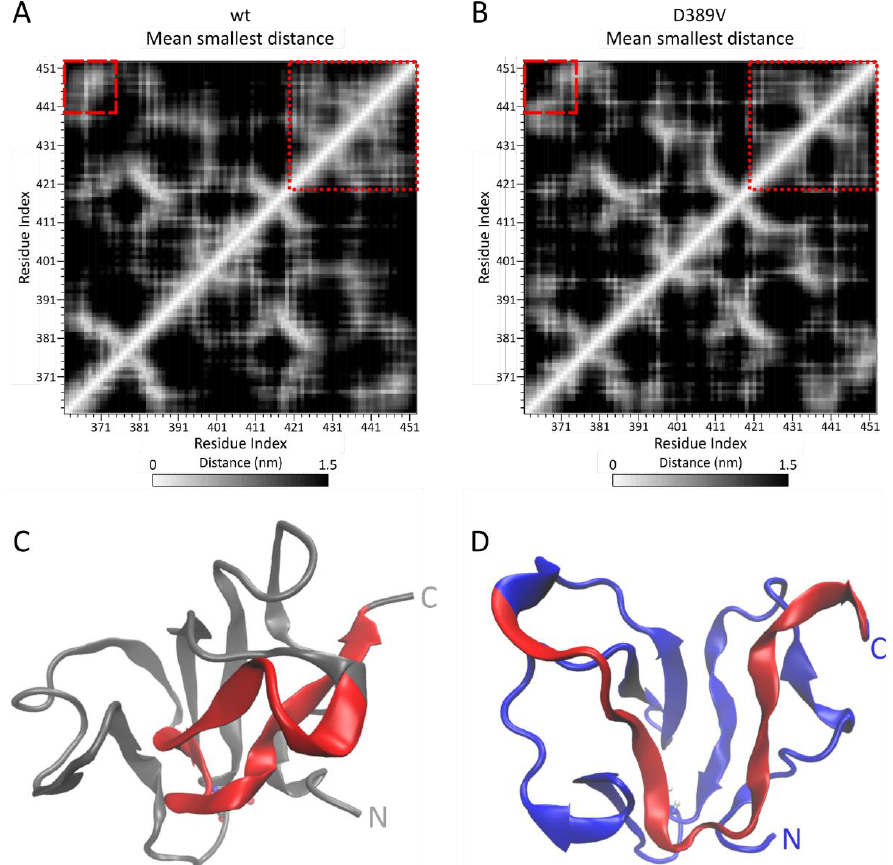
Figure 4. Mean smallest distance matrices for MyBPC C2 wt ( A ) and D389V ( B ). The time-averaged minimum distance of each residue to every other residue is plotted in heat maps with white indicating the smallest distance and black indicating the largest distance ranging from 0 to 1.5 nm. This map reveals differences in the global conformational space of C2 wt and D389V. Dotted boxes indicate the β 4–5–6 interstrand contacts within the C-terminus of the domain. Dashed boxes indicate the β 1–6 interstrand contacts of C2 wt that are destabilized in C2 D389V (for topology see Figure 1D). ( C , D ) Sample structures of C2 wt (grey) and D389V (blue) to illustrate the differences in C-terminal conformation regarding the dotted boxes in ( A , B ). Residues 430 to 450 are marked in red.